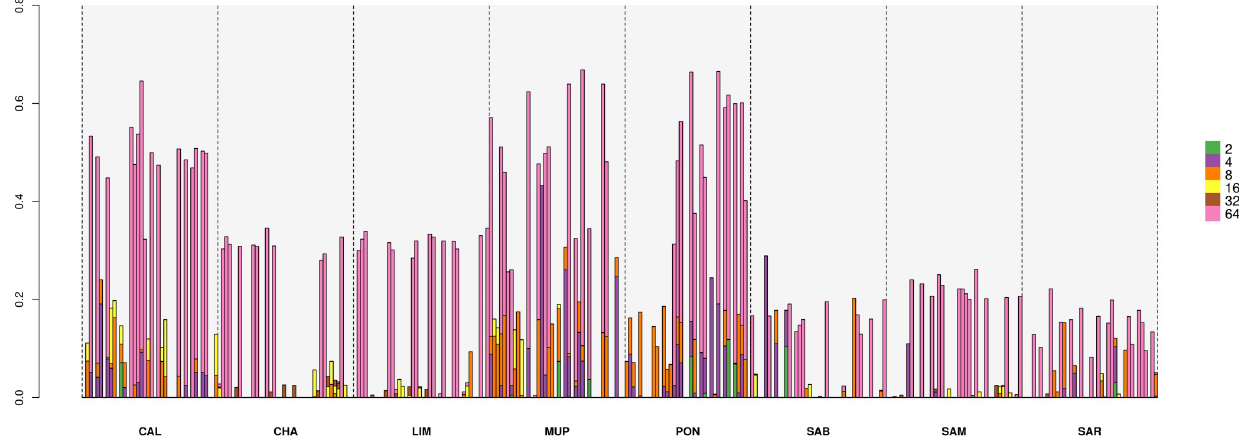
Fig 10. Proportion of the genome interested by HBD classes in different R K . CAL = Calvana; CHA = Charolais; LIM = Limousine; MUP = Mucca Pisana; PON = Pontremolese; SAB = Sardo Bruna; SAM = Sardo Modicana; SAR = Sarda.